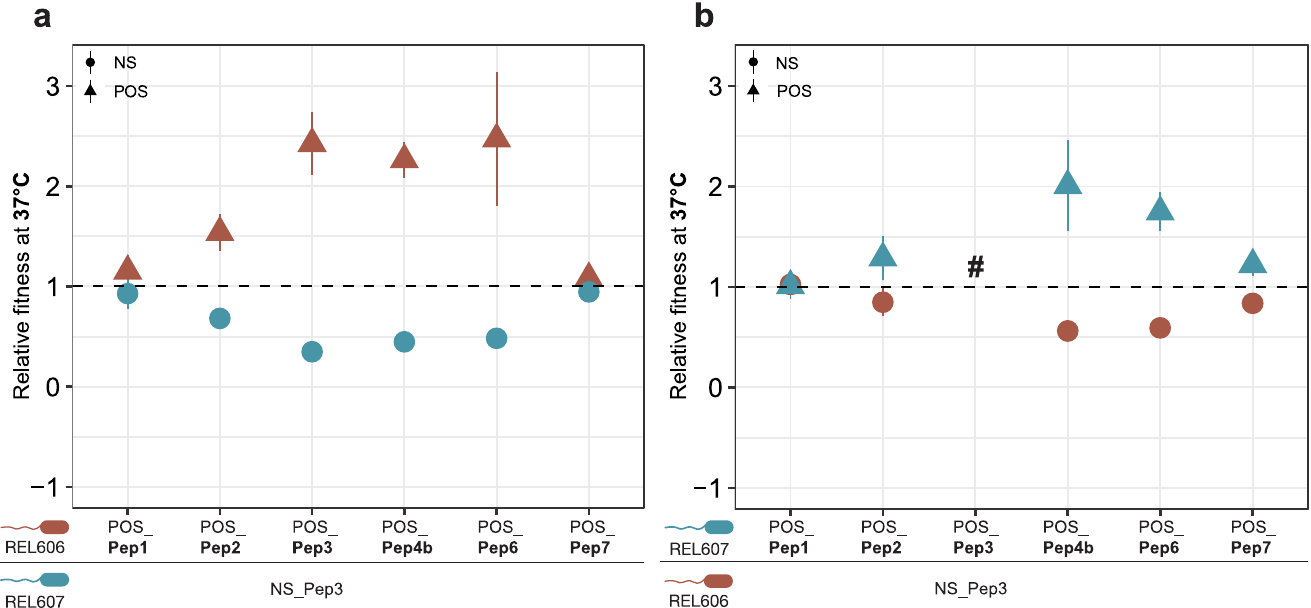
Figure 6. Competitive fitness analysis for six POS_Pep clones. The respective plasmids were cloned into the E. coli B REL606 and REL607 ancestor backgrounds that produce red and pink colonies, respectively, on TA indicator plates (see Methods). The competitor in each experiment was the NS_Pep3 clone. ( a , b ) represent the experiments for swapped backgrounds to ensure that there are no background-specific effects. The symbol # represents missing data. At least four replicates were used for each experiment. Whiskers represent the SEM.